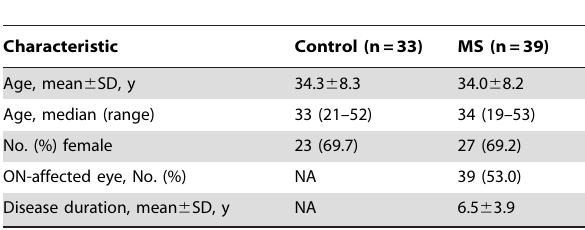
Table 1. Clinical characteristics of the study